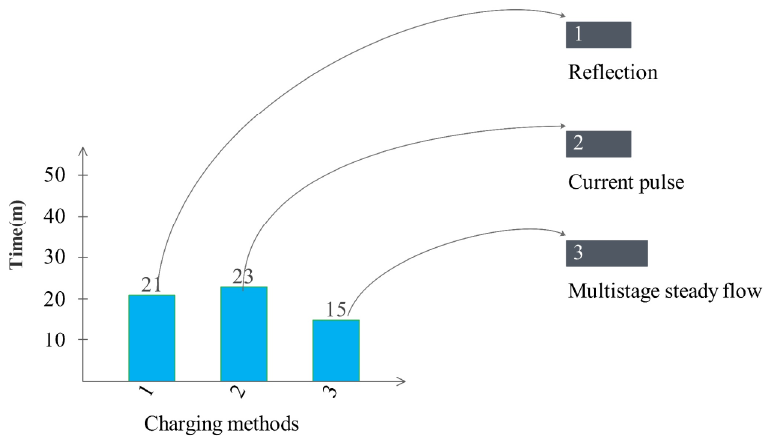
Figure 11. Comparison of charging time in fast charging methods.